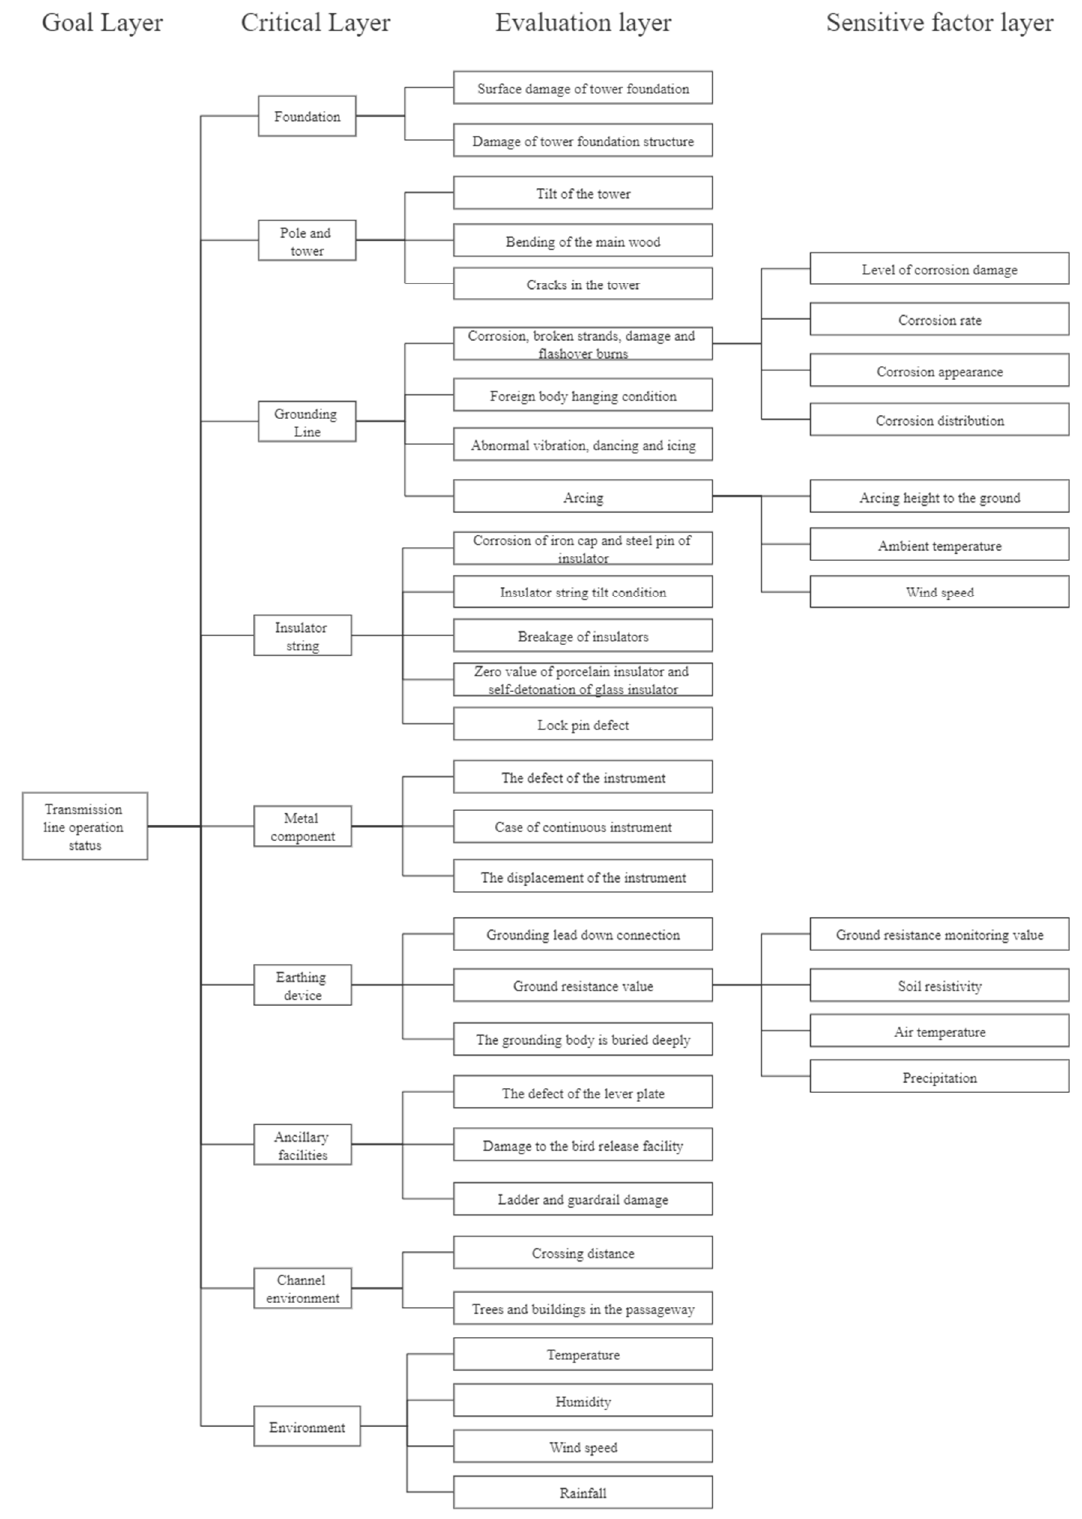
Figure 1. Schematic diagram of the hierarchical model.